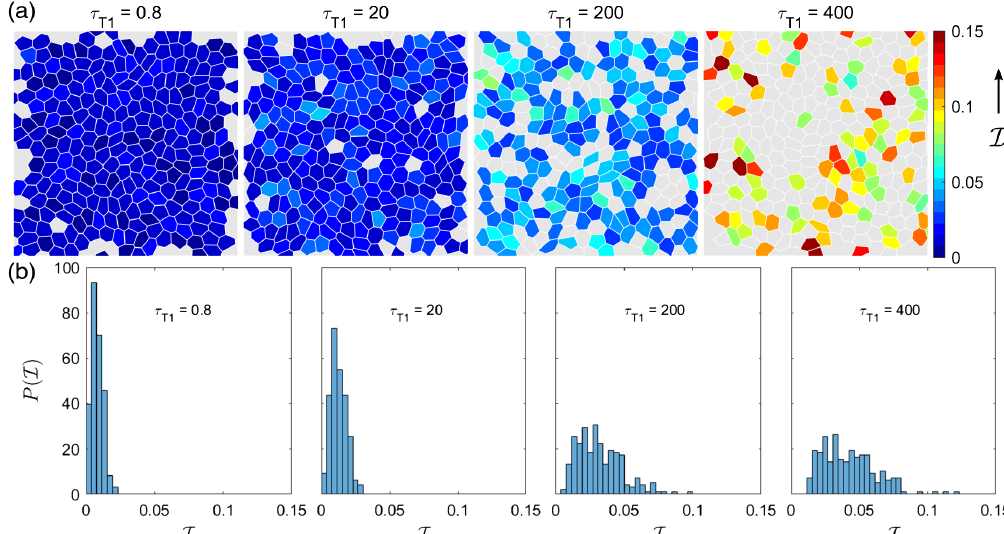
FIG. 4. Fast cells organize into streams as T1 stalling time increases. (a) Simulation snapshots for four different τ v 1 . 6 . Only the fast cells are shown (net displacement d 0 ¼ to their intercalation efficiencies, defined as I ¼ d ∞ =n different τ T 1